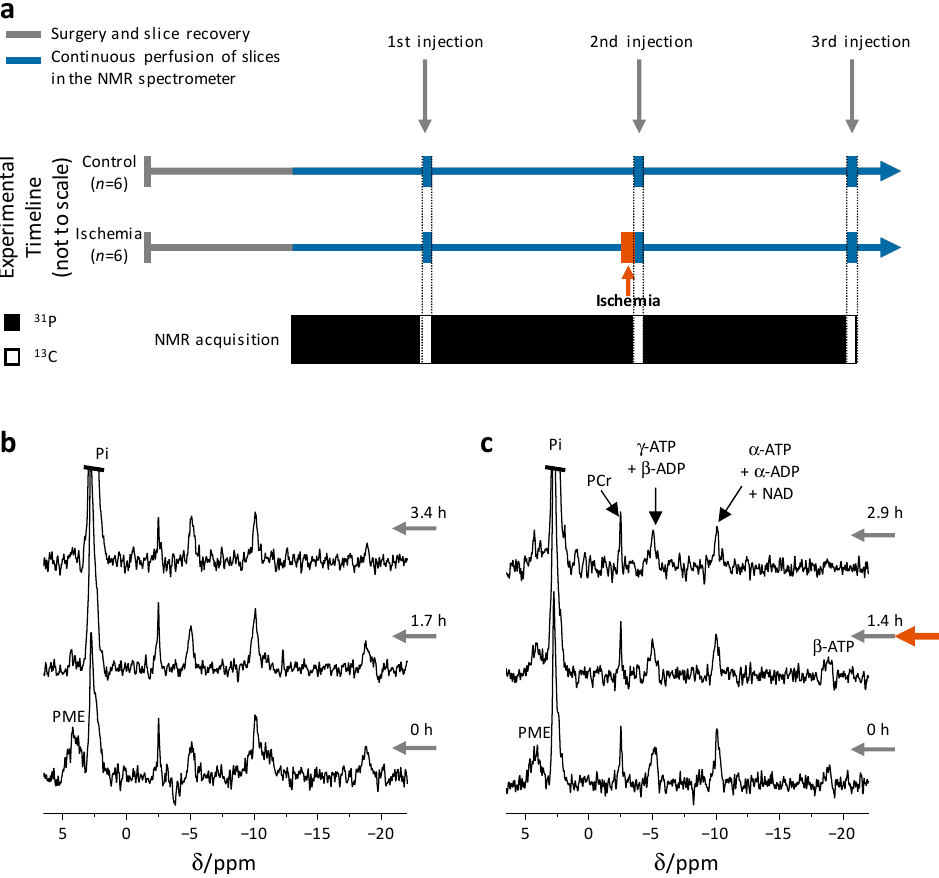
Figure 1. Experimental timeline and slice viability throughout the experiments. ( a ) Experimental workflow. Following surgery and slice recovery (solid grey timeline), the brain slices were placed in the NMR tube and were continuously perfused therein (solid blue timeline). The control group was maintained in this state for the entire duration of the experiment. The 1st injection of hyperpolarized medium was administered about 1 h following the start of perfusion in the NMR spectrometer. About 1.5 h after the 1st injection, the 2nd injection of hyperpolarized medium was administered. For the ischemia-reperfusion group, perfusion was stopped for ca. 11 min (brown rectangle) prior to the 2nd injection. A third injection was performed about 1.5 h after the 2nd injection. Injections are marked by grey arrows and the injection times are marked per injection. Injections coincide with 13 C acquisitions, and 31 P acquisitions are performed before and after the injections. ( b ) Typical 31 P NMR spectra acquired from brain slices during continuous perfusion in the spectrometer during a control experiment. ( c ) Typical 31 P NMR spectra acquired from brain slices in the perfusion system during an experiment with an ischemic insult. The ischemic insult (brown arrow) was applied once the acquisition of the middle 31 P spectrum was completed. The second injection was administered at the end of the ischemic insult (and provided reperfusion). Times are indicated in h (the time of the first injection of [1- 13 C]pyruvate was referred to as t = 0). The acquisition of the 31 P spectra was completed before each injection (for the second injection, the acquisition was completed before the ischemic insult). Each spectrum was acquired over 1 h, using 3,296 excitations (1.1 s repetition time, 50 ° nutation angle, in batches of 412 scans). The spectra were processed with a line-broadening of 7 Hz and zero-filled from 8,192 to 16,384 points. The spectra were referenced to the PCr signal at − 2.5 ppm. The baseline was manually corrected. The signal of Pi was truncated for better visualization of the high-energy phosphates’ signals. The increase in the relative intensity of the Pi signal in the